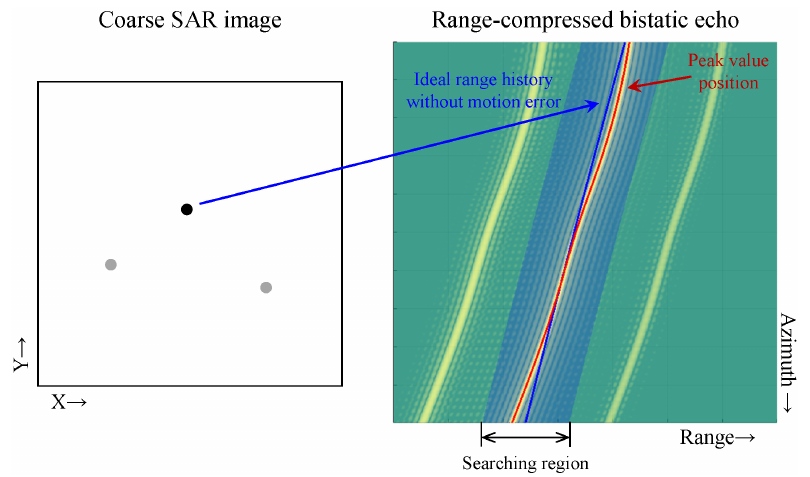
Figure 3. Azimuth signal extraction by